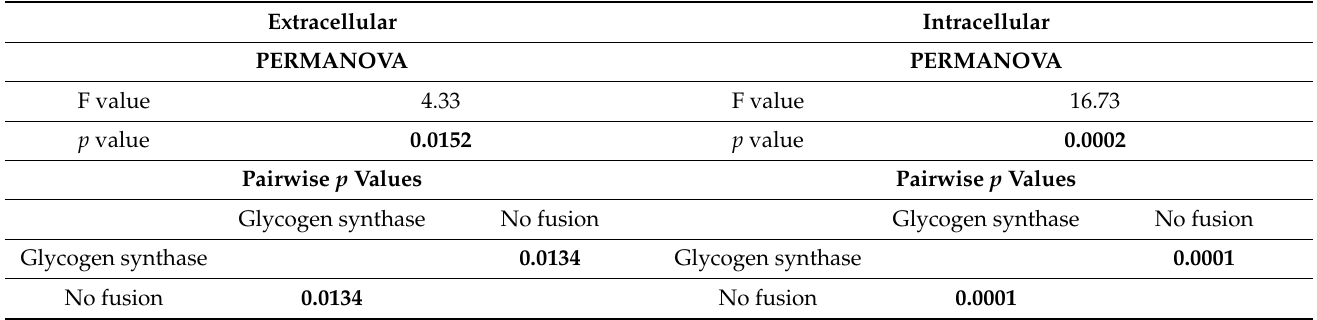
Table 7. A summary of PERMANOVA (distance) test data for the extra- and intracellular faces of the orexin receptors, to support Figure 5; 9999 permutations performed on PC1-5, significant p values (<0.05) are shown in